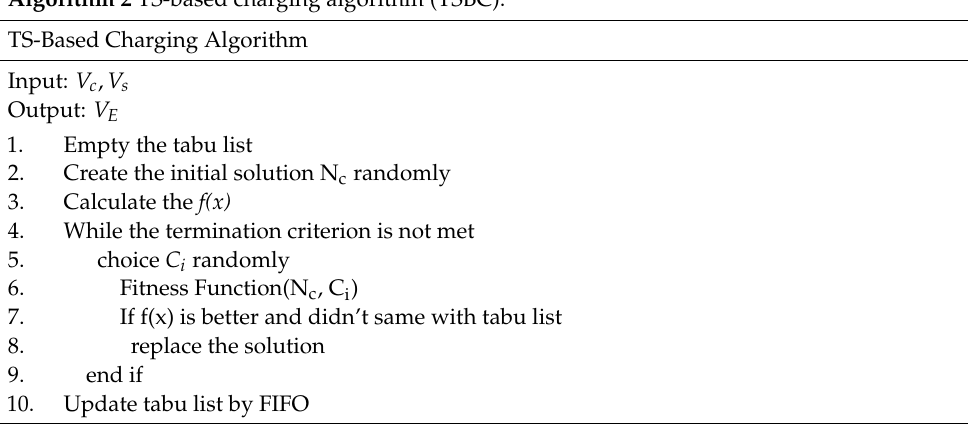
Algorithm 2 TS-based charging algorithm